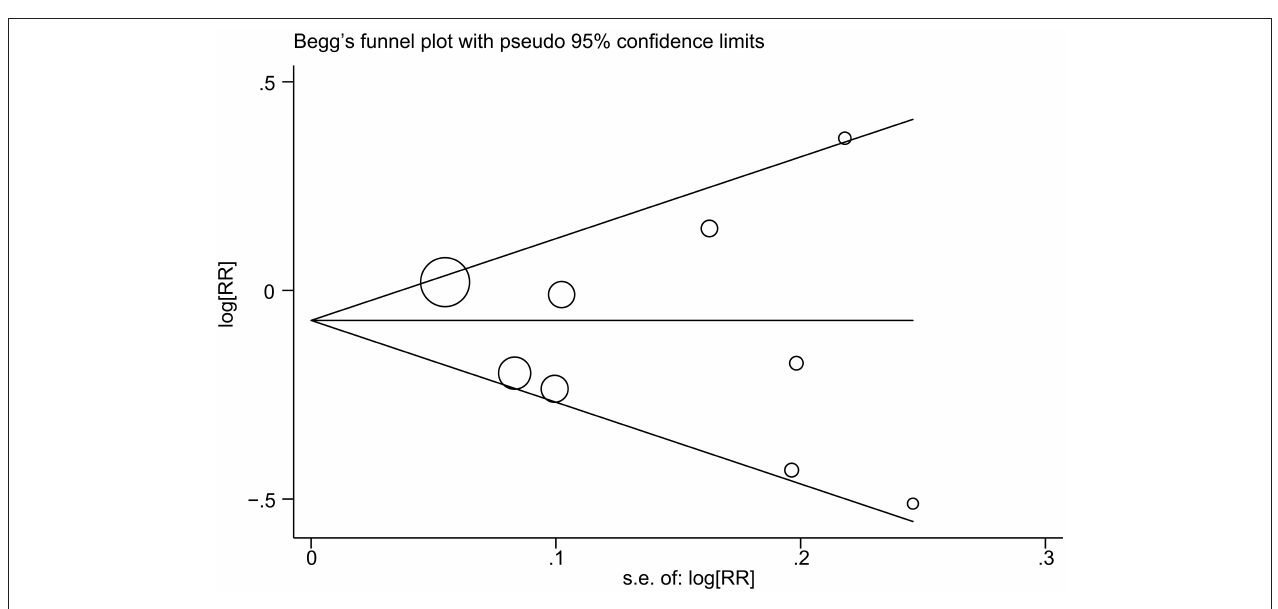
FIGURE 4 | Publication bias was assessed with a Begg’s funnel